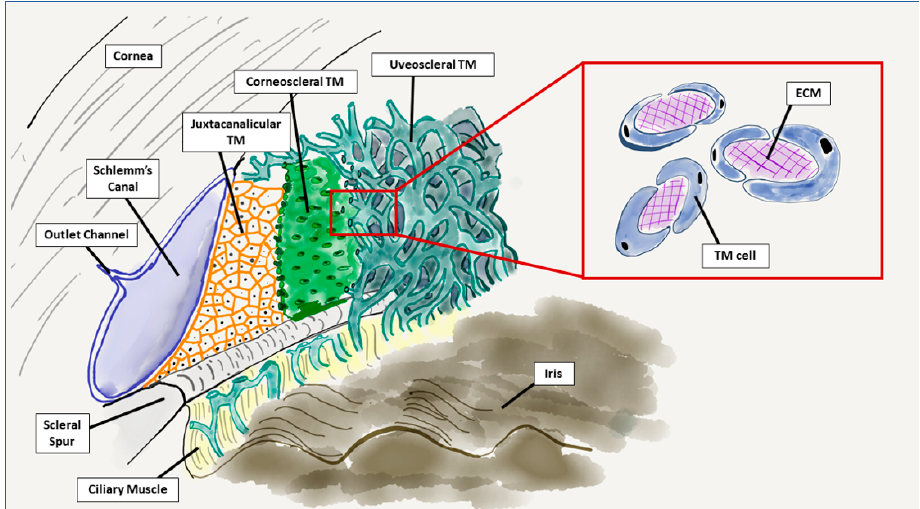
Figure 4. Configuration of the trabecular meshwork. In both the corneoscleral and uveoscleral layers, the trabecular meshwork cells wrap around a core of extracellular matrix components. Note the increasingly large intertrabecular pores between the trabecular meshwork beams in the deeper layers. In the juxtacanalicular layer, the extracellular matrix and the trabecular meshwork cells have a more irregular and interwoven spatial relationship.